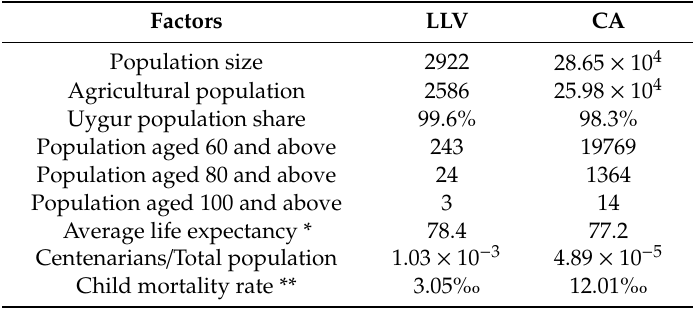
Table 3. Comparative statistics of population status in LLV and